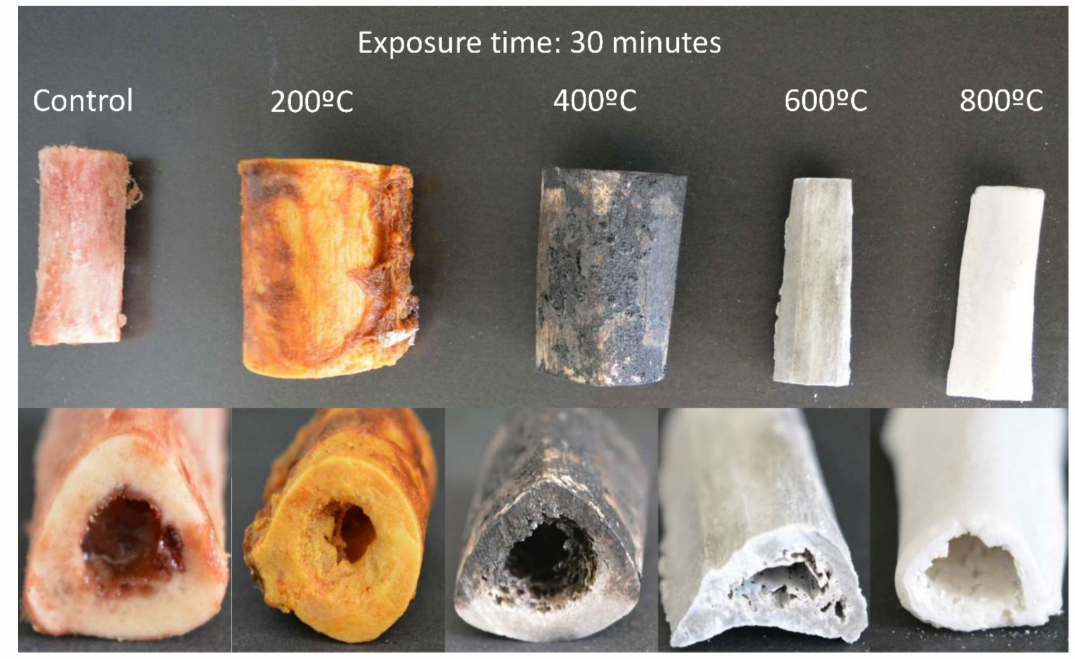
Figure 1. Color changes in bones after exposure at di ff erent temperatures (°C) for 30 min. From left to right: tibia, femur, tibia, ulna, and